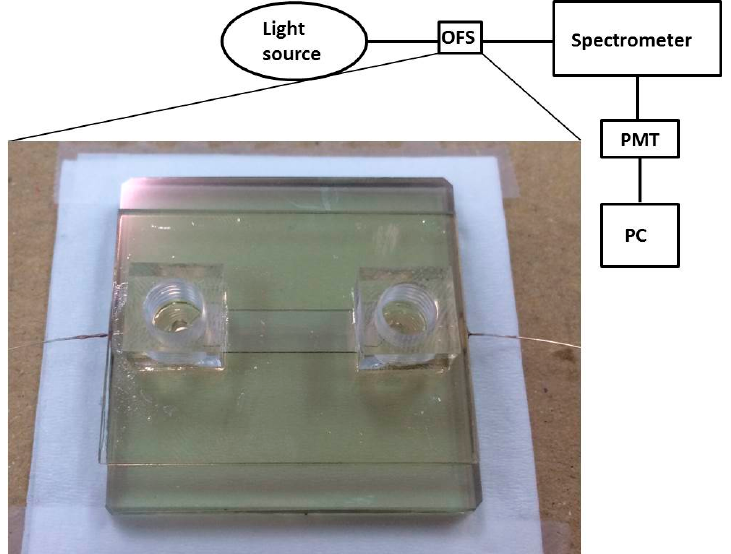
Figure 4. The experimental setup composed of a light source, the microfluidic chip-integrated OFS, a spectrometer, and a photomultiplier